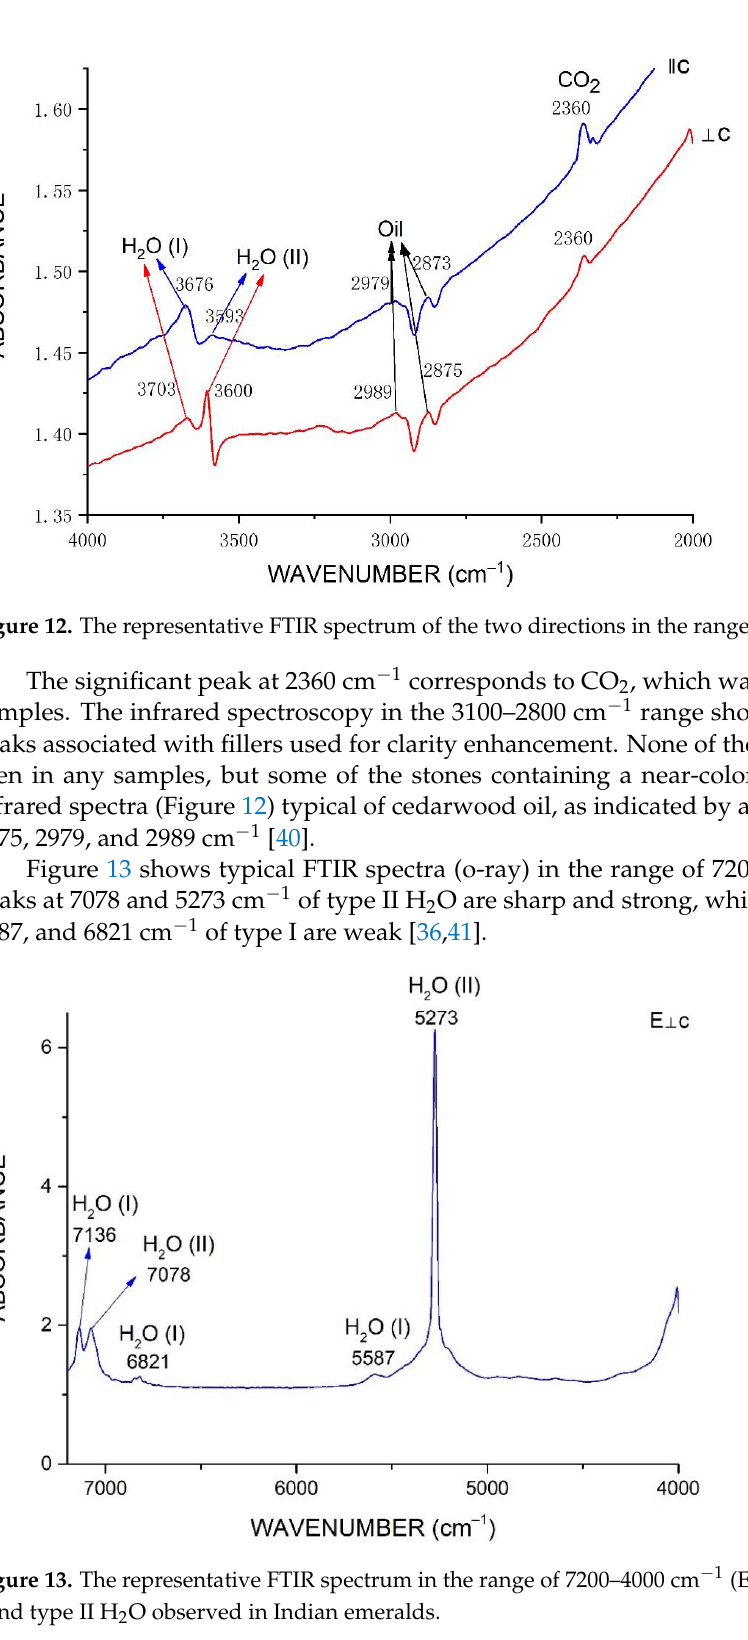
Figure 13. The representative FTIR spectrum in the range of 7200–4000 cm − 1 (E ⊥ C) illustrating type I and type II H 2 O observed in Indian emeralds.